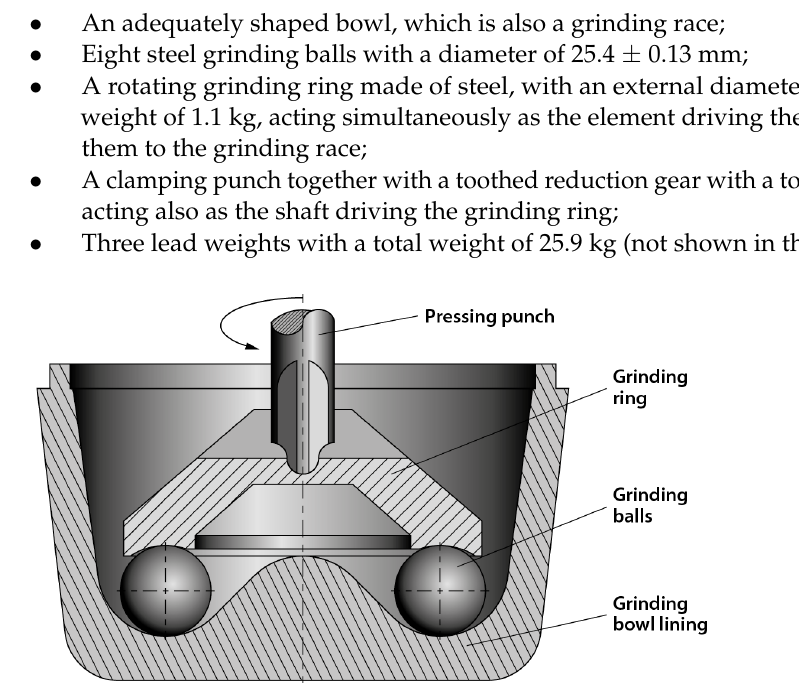
Figure 1. The system built in 1932 by R.M. Hardgrove to determine the grindability index. Self- prepared based on [29].